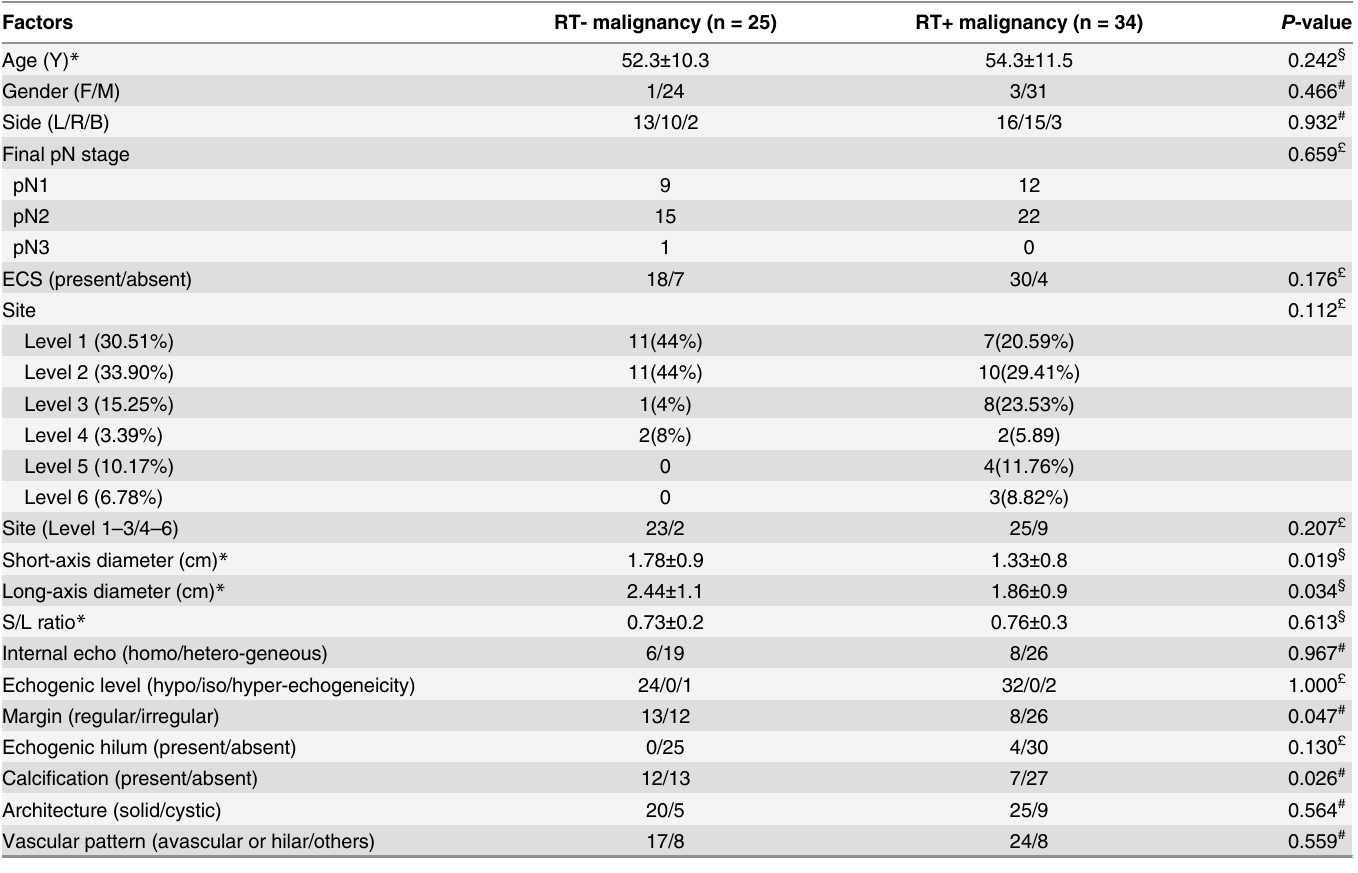
Table 4. A comparison of demographic features of malignancy in treated OSCC patients without previous neck RT (RT-) and those with prior neck irradiation